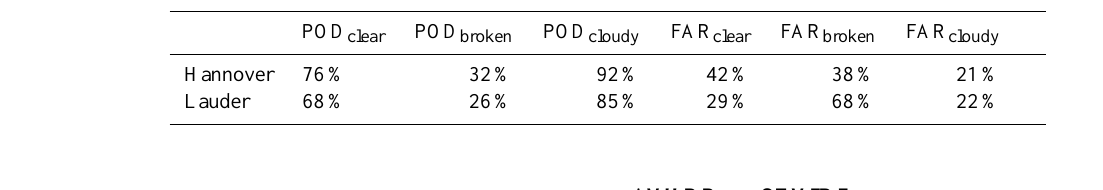
Table 4. POD clear , POD broken , POD cloudy , FAR clear , FAR broken and FAR cloudy (clear: cloud-free, broken: cloud-contaminated, cloudy: cloud-covered) in % between HSI and AVHRR in Hannover, Germany, from 1 July to 30 September 2009 (not matched to SEVIRI) and